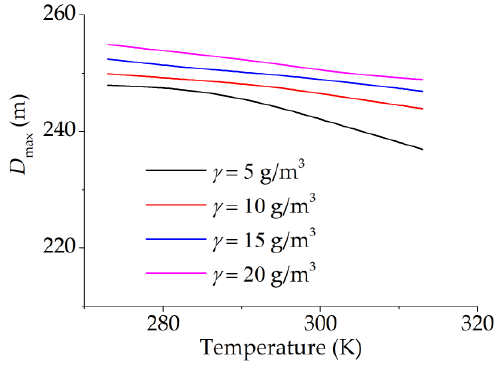
Figure 8. The variation of D max with changing of temperature and atmospheric pressure.